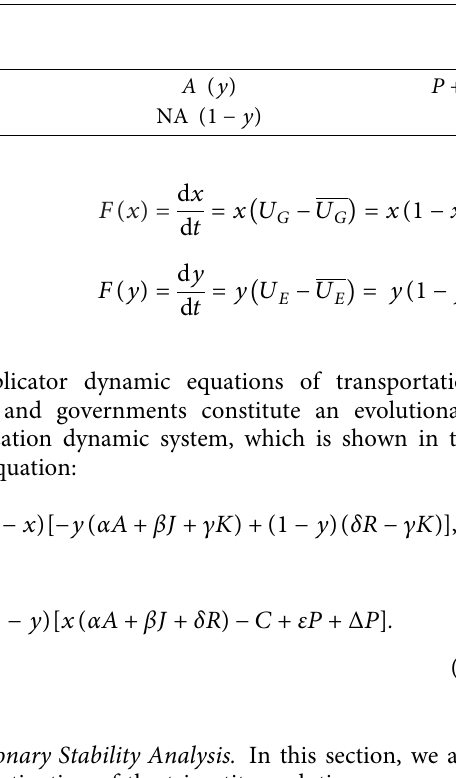
Table 2: Payoff matrix between governments and